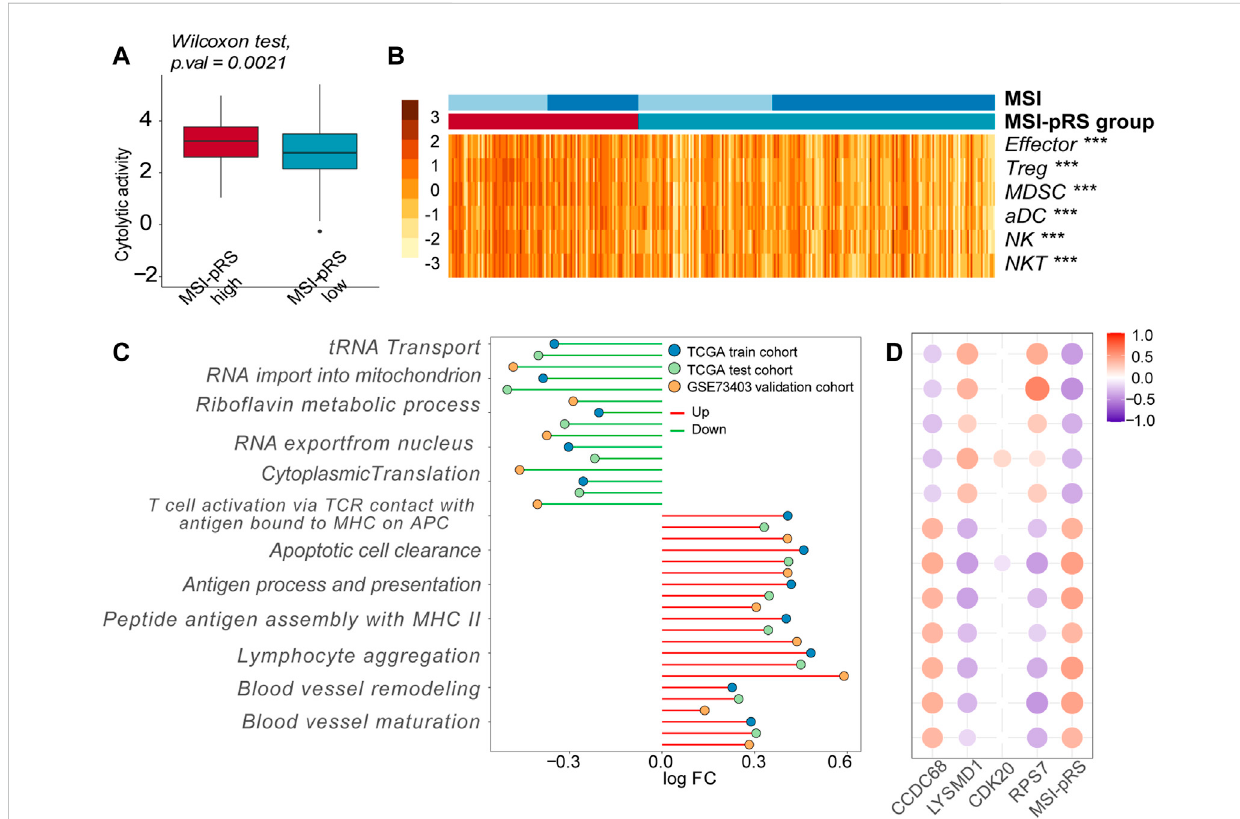
FIGURE 12 Immune features exploration ofthe MSI-related prognosticriskscore (MSI-pRS). (A) Cytolyticactivity (CYT) washigher intheMSI-pRS high group in the training cohort. (B) Heatmap of immune cells in tumor microenvironment in the training cohort. (C) Lollipop plot of the altered biological processes concentrating on the immune process and cell cycle, according to the MSI-pRS group in the three cohorts. (D) Correlation plot of the four genes in the MSI-pRS model and the altered biological processes in the TCGA training cohort. Abbreviation: LUSC, lung squamous cell carcinoma; MSI, microsatellite instability; MSI-pRS, MSI-related prognostic risk score; ICIs, immune checkpoint inhibitors; CYT, cytolytic activity; TME, tumor microenvironment; TP53, tumor protein p53; PD-L1, programmed death-ligand 1; MLH, MutL homologs; MSH, MutS homologs; TCGA, The Cancer Genome Atlas; GEO, Gene Expression Omnibus; GSEA, gene set enrichment analysis; WGCNA, weighted correlation network analysis; GO, Gene Ontology; OS, overall survival time; PFS, progression-free survival; DCA, decision curve analyses; HR, hazard ratios; ROC, receiver operating characteristic;AUC,areaundertheROCcurve;DEGs, differentiallyexpressedgenes;DMPs,differentmethylationprobes;MHC,major histocompatibility complex; CCDC68, coiled-coil domain containing 68; RPS7, ribosomal protein S7; CDK20, cyclin-dependent kinase 20; and LYSMD1, LysM domain containing